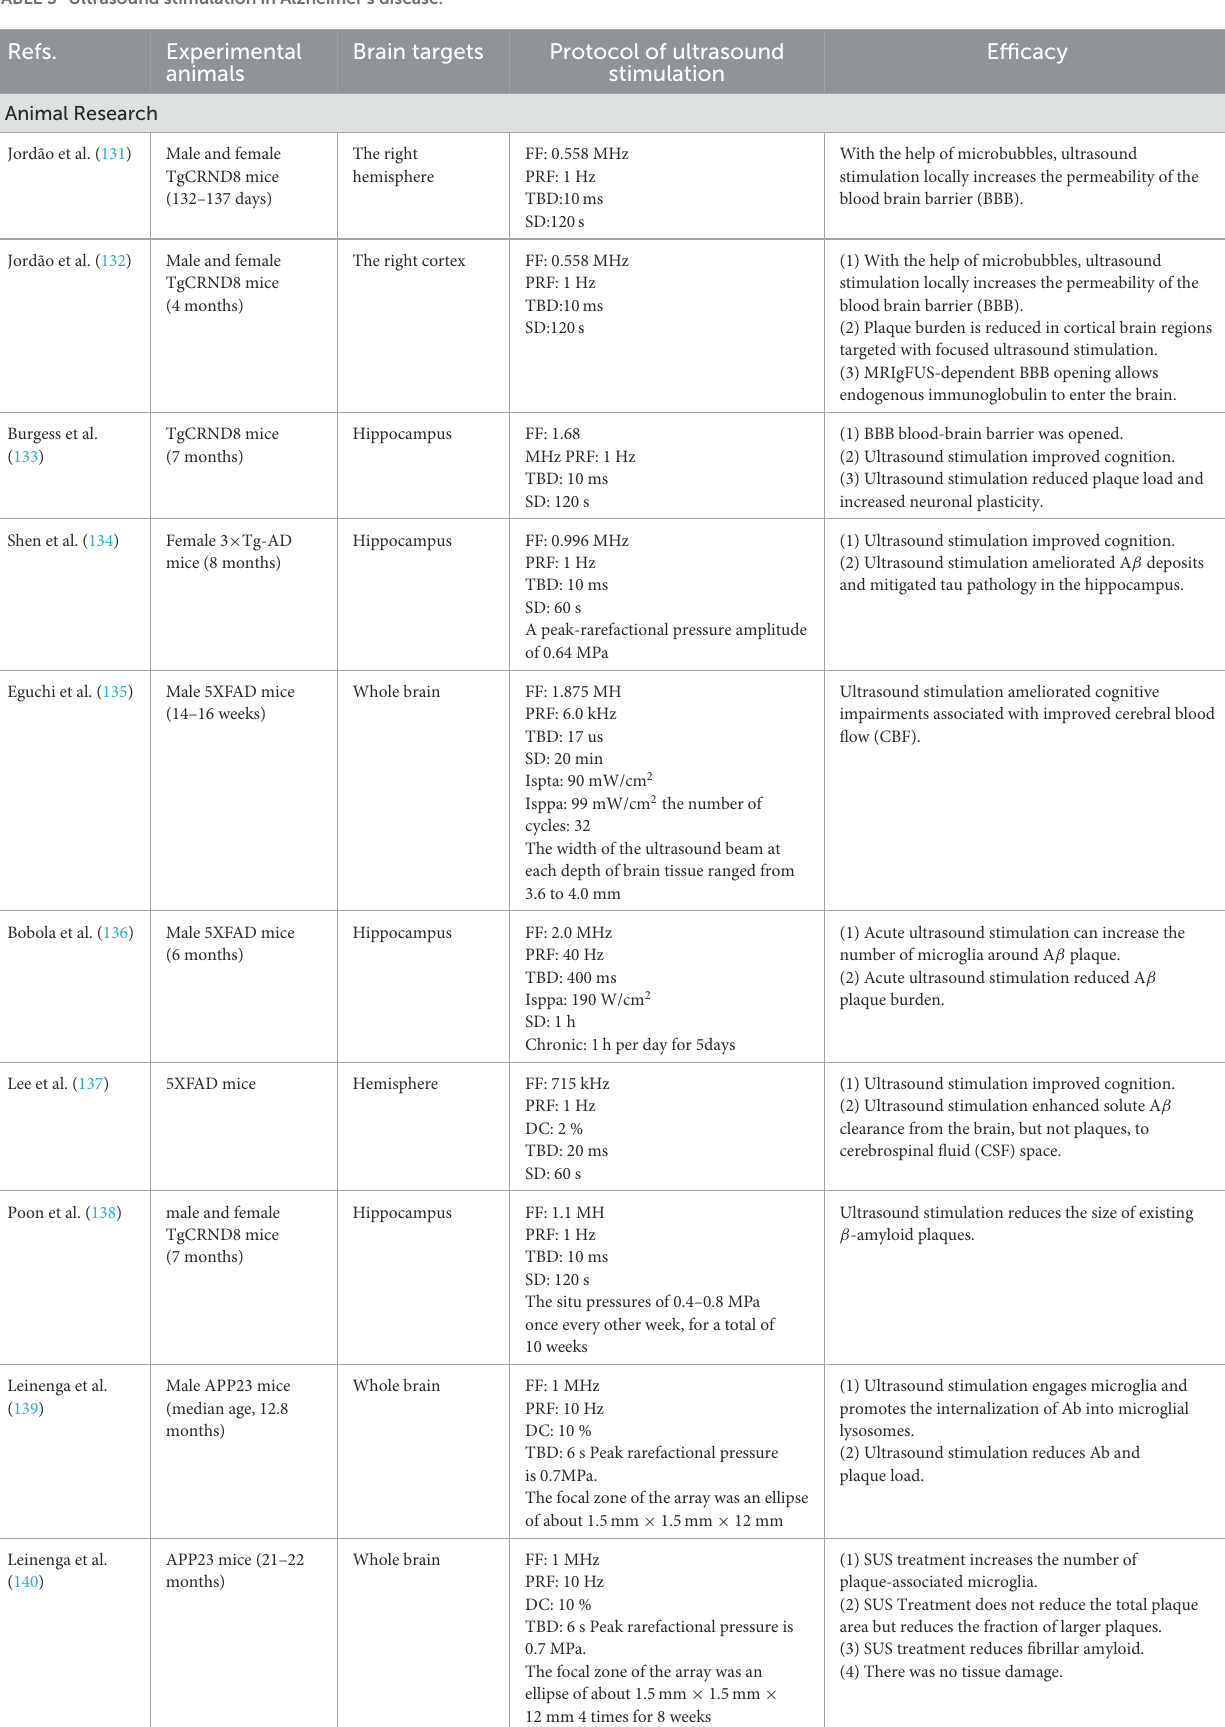
TABLE 3 Ultrasound stimulation in Alzheimer’s disease.